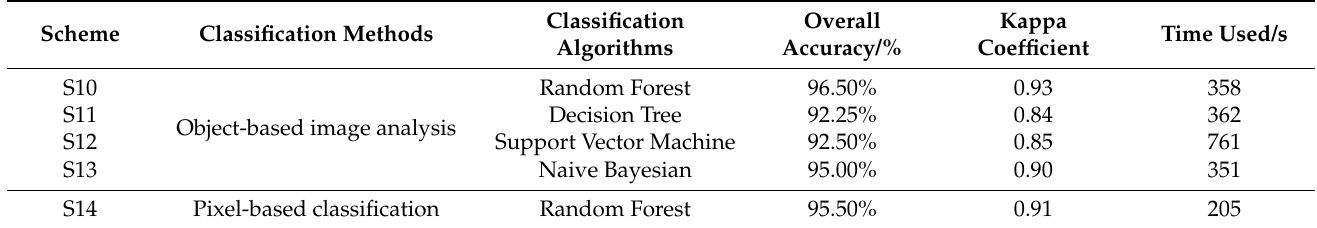
Table 6. Comparison of accuracy of different classification algorithms for COTC